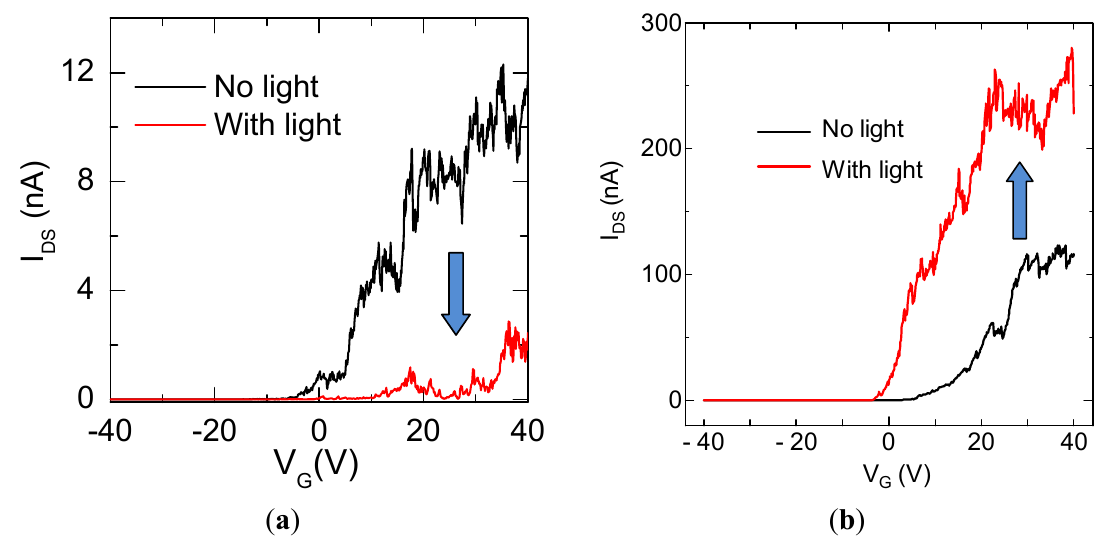
- V characteristics ( V Figure 5. I DS G with a light pulse (400 nm) at V